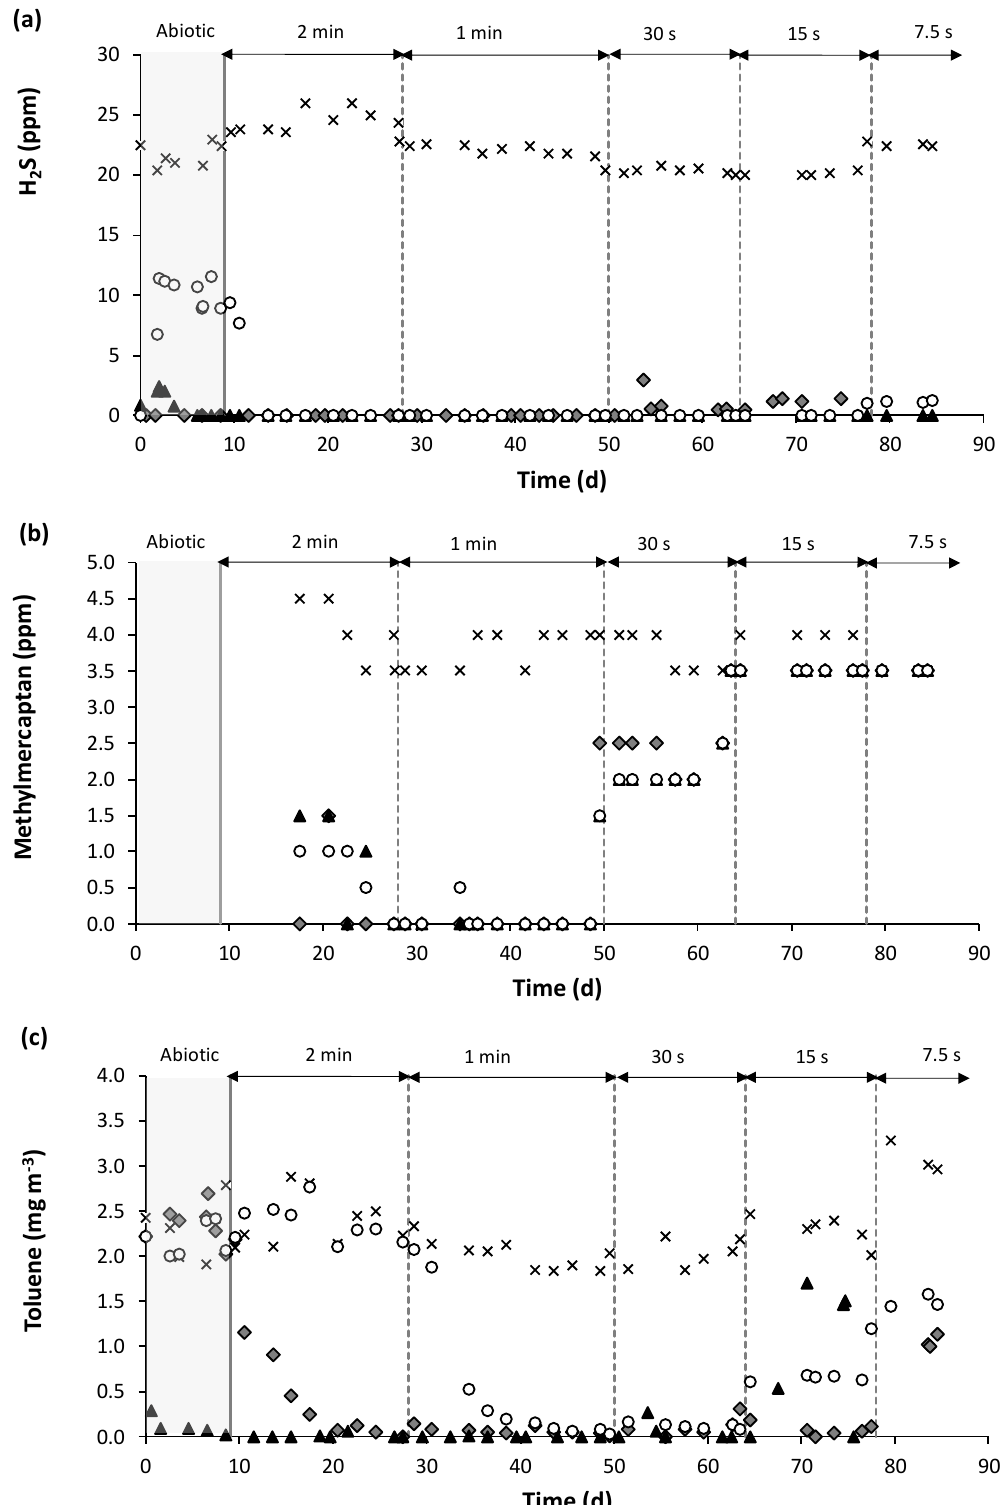
Figure 2. Time course of the inlet (×) and outlet concentration of H 2 S ( a ), methylmercaptan ( b ) and toluene ( c ) in BTF-F ( ), BTF-FAC ( ), BTF-K ( ). Vertical dashed lines delimit different stages.